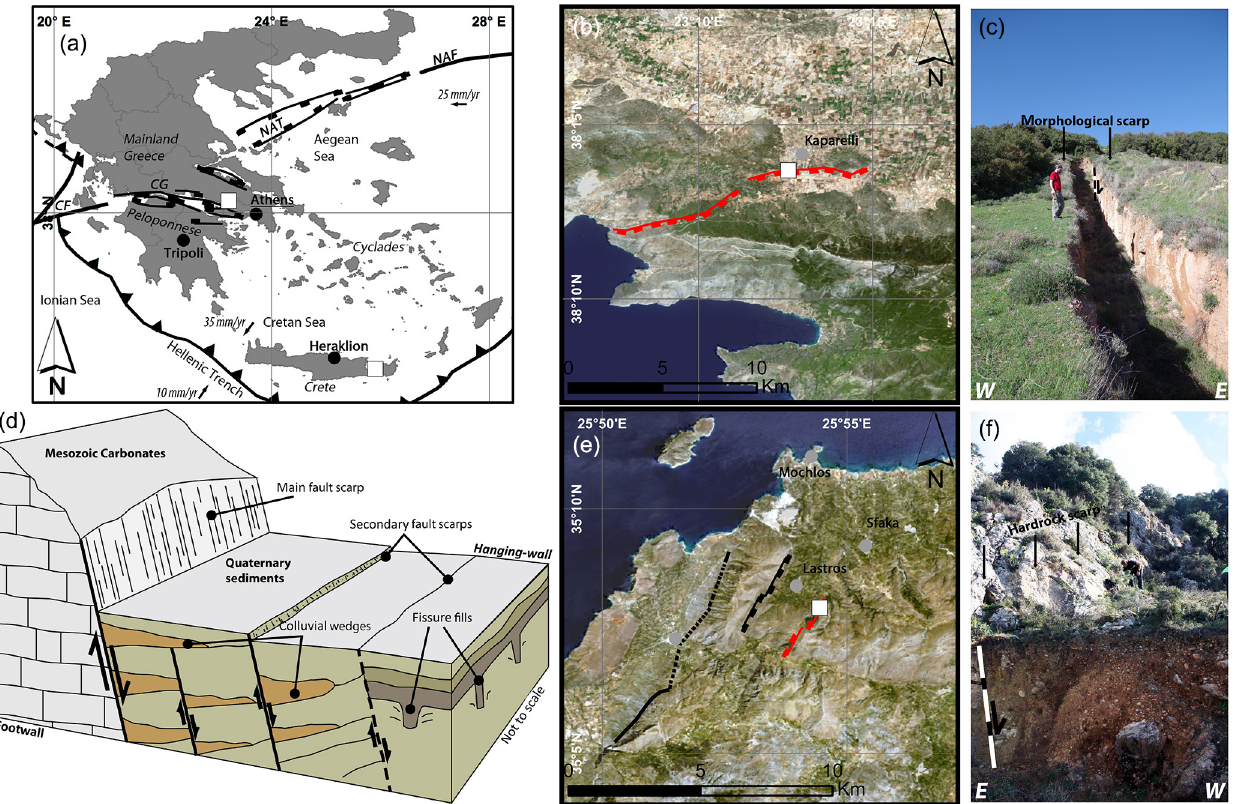
Figure 1. Guide to the study area. (a) Map of Greece showing simplified large-scale tectonic structures (CG, Corinthian Gulf; CF, Cephalonia Fault; NAF, North Anatolian Fault; NAT, North Aegean Trough; black lines with barbs show active thrusts; black lines with marks show active faults) (after Kokkalas and Koukouvelas, 2005; Papanikolaou and Royden, 2007). White boxes highlight study areas. (b) Satellite image (Landsat 8, 2015) of the easternmost Gulf of Corinth. The Kaparelli Fault is shown in red and the white box marks the position of the palaeoseismological trench of Kokkalas et al. (2007). (c) View of the Kaparelli trench. (d) Satellite image (Landsat 8, 2015) of the study area at the Sfaka Fault (red) in northeastern Crete; the white box shows the position of the road cut along strike. (e) View of the Sfaka road cut. (f) Sketch of a typical postglacial normal fault showing bedrock juxtaposed against Quaternary sediments which contain structures caused by recurrent earthquakes (modified after Reicherter et al., 2003). Colluvial wedges form at the base of the fault scarp from eroded material originating at the top of the